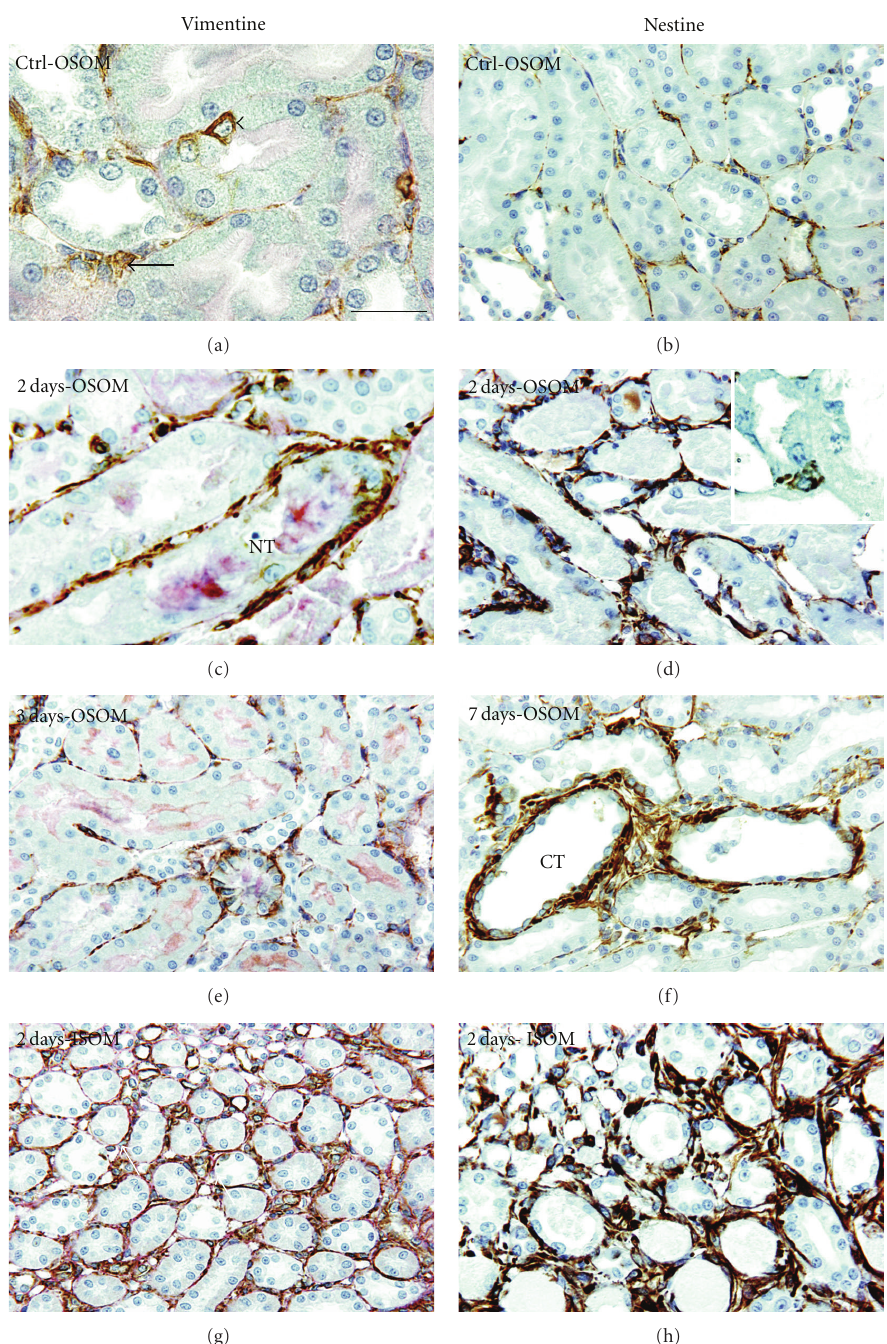
Figure 5: Distribution of vimentin-positive cells (left column) and of nestin-positive cells (right column) in the renal interstitium of control (a, b) or at di ff erent time intervals after ischemia-reperfusion (c–h). In control (a), vimentin-positive fusiform cells are scarce within interstitium (arrows) of OSOM. Focally in S3 tubules, undi ff erentiated epithelial cells devoid of brush border (arrowhead) appeared positive. Two and three days after reperfusion (c, e) vimentin-positive fusiform cells are localized around S3 necrotic tubules (NT) in OSOM. At the same period (2 days—(g)), their density is higher within ISOM. (b) Distribution of nestin positive cells in interstitium of OSOM in a control animal. Two days after reperfusion (d), nestin-positive fusiform cells form a dense network around necrotic tubules (NT) in OSOM. Focally, isolated epithelial cells appeared positive in altered tubules (d inset). Later, 7 days after reperfusion (f), positive cells are restricted to periphery of cystic tubules (CT). In ISOM (h), the density of fusiform positive cells is particularly high 2 days after reperfusion. Scale bar. 18 μ m: (a, c); 25 μ m: (d); 30 μ m: (b, e, f, g,